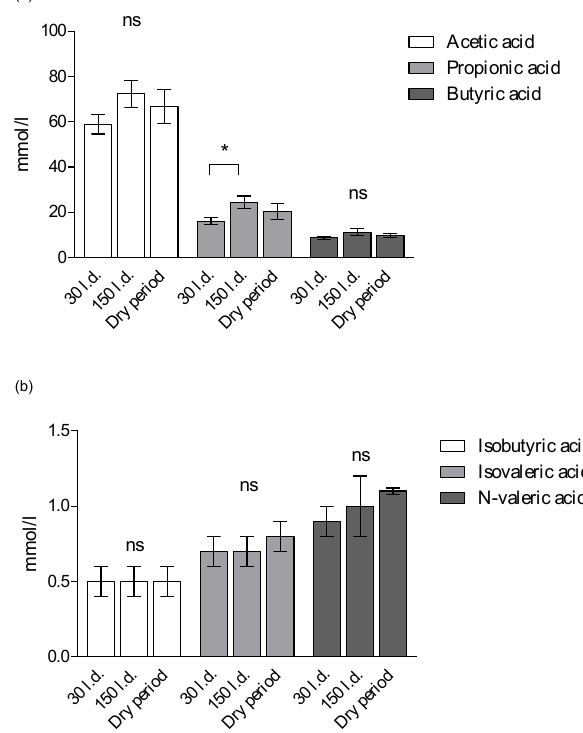
Figure 2. RSCFA concentrations in the rumen contents of Holstein cows during the production period: (a) concentrations of acetic, propionic, and butyric acids; (b) concentrations of isobutyric, iso- valeric, and n -valeric acid. l.d.: lactation day; ns: non-significant; ∗ significant difference between sampling periods at P < 0 . 05.